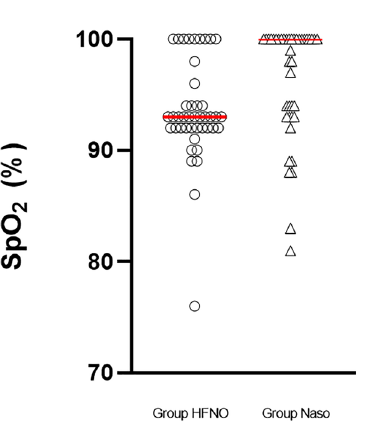
Figure 3. (A) Proportion of patients with SpO 2 ≥ 95% during 20 min apnoea (HR 0.3, 95% CI 0.2 to 0.6, P < 0.001). ( B) Safe apnoea time between the two groups, horizontal line = median. The safe apnoea time of the patients in the Group Naso was higher than that of the patients in the Group HFNO [20 (19.3 to 20.0) vs. 16.5 (12.9 to 20) min, P < 0.05].